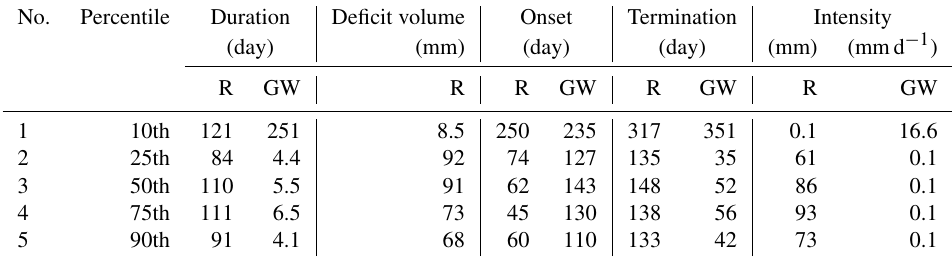
Table 2. Drought characteristics based on percentiles areas in Europe (e.g. 10th percentile means the 10% driest area in Europe).